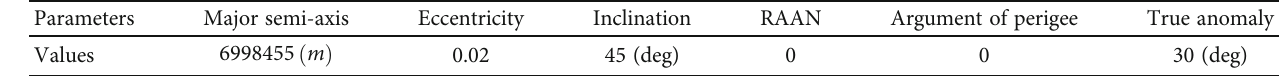
Table 1: Orbit parameters of chaser satellite.